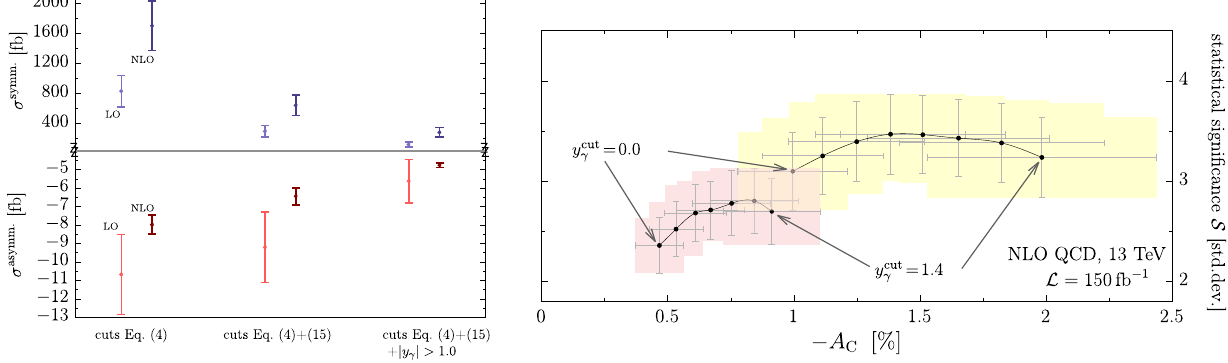
Fig. 2 Left: Symmetric and asymmetric cross sections at LO and NLO QCD for different sets of cuts. The error bands correspond to a scale variation by a factor two around the central scale μ 0 . Right: Statistical significance as a function of the (negative) charge asymmetry at NLO